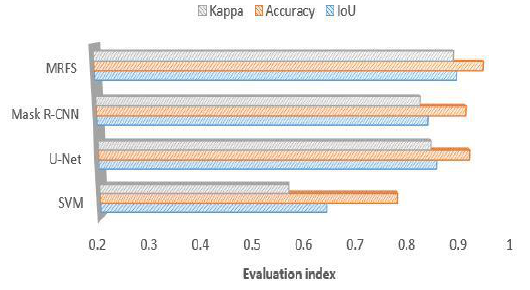
Figure 11. Comparison of MRFS, Mask R-CNN, SVM and KNN on medium sized area c.